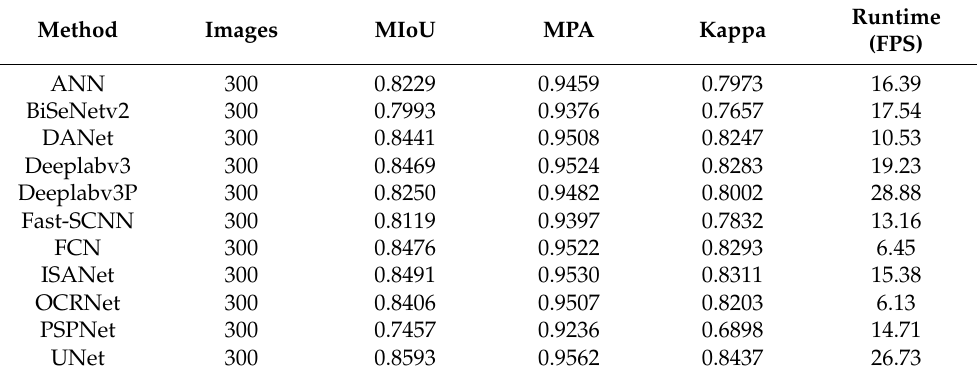
Figure 15. Segmentation result of 11 models on the left eye data. Table 2. Comparison of performance indicators of the 11 models on the left eye data.